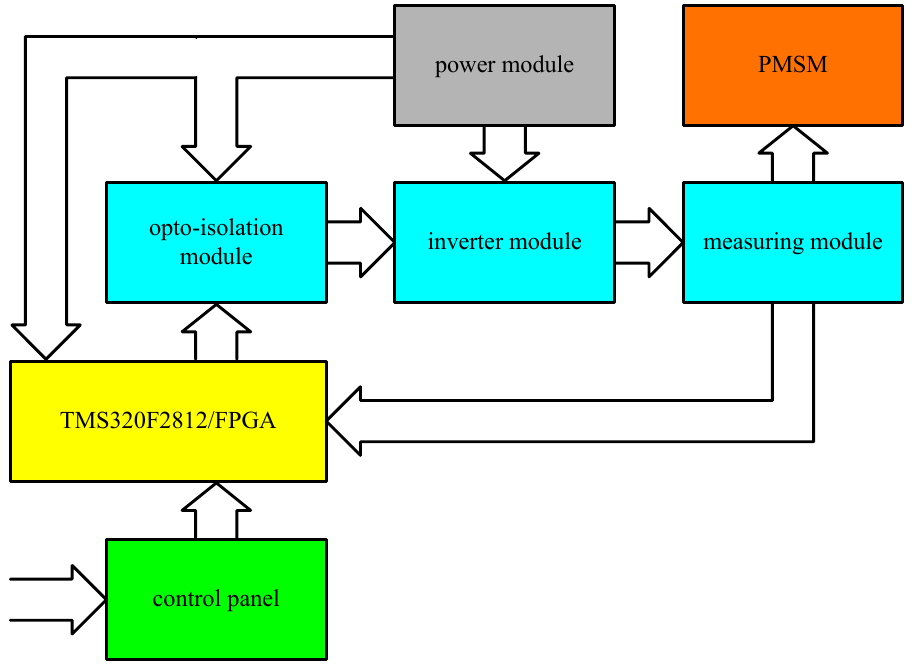
Figure 5. A detailed block diagram of the control unit.